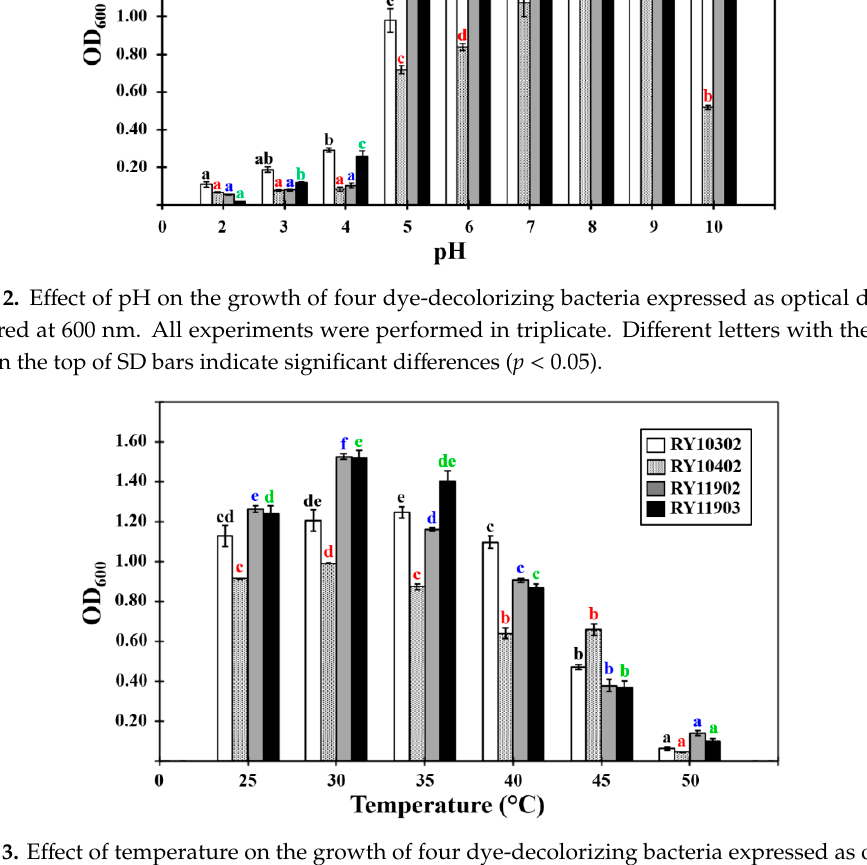
Figure 4. Effect of salinity on the growth of four dye-decolorizing bacteria expressed as optical density measure at 600 nm. All experiments were performed in triplicate. Different letters with the same color on the top of SD bars indicate significant differences ( p < 0.05). 3.5. Genotypic Identification of Dye-Decolorizing Bacteria Dye-decolorizing bacteria were genetically identified by PCR amplification and nucleotide analysis of 16S rRNA gene. Alignment using the BLASTn program revealed that the bacterial strain RY10302 was closely similar to Klebsiella pneumoniae strain DSM 30104 with 97% query coverage and 99.02% identity. Three strains of dye-decolorizing bacteria, including strains RY10402, RY11902 and RY11903, were closely similar to Enterobacter tabaci strain YIM Hb-3 with 98–100% query coverage and 97.38–98.36% identity. The genotypic identification of dye-decolorizing bacteria is shown in Table 3. The E values of all BLASTn alignment results were zero. A phylogenetic tree in terms of cladogram using the BIONJ algorithm with 100,000 bootstrap replications is shown in Figure 5. All nucleotide sequences of 16S rRNA genes from this study were deposited in the GenBank database of NCBI under the accession numbers MT355793, MT355794, MT355797 and MT355798, as previously mentioned in the “Materials and Methods” section. Indeed, the bacterial strain RY10302 was confidently designated as K. pneumoniae strain RY10302. The other three strains were designated in the genus level as Enterobacter sp. due to their percentages of identity obtained from BLASTn program being lower than 99%.